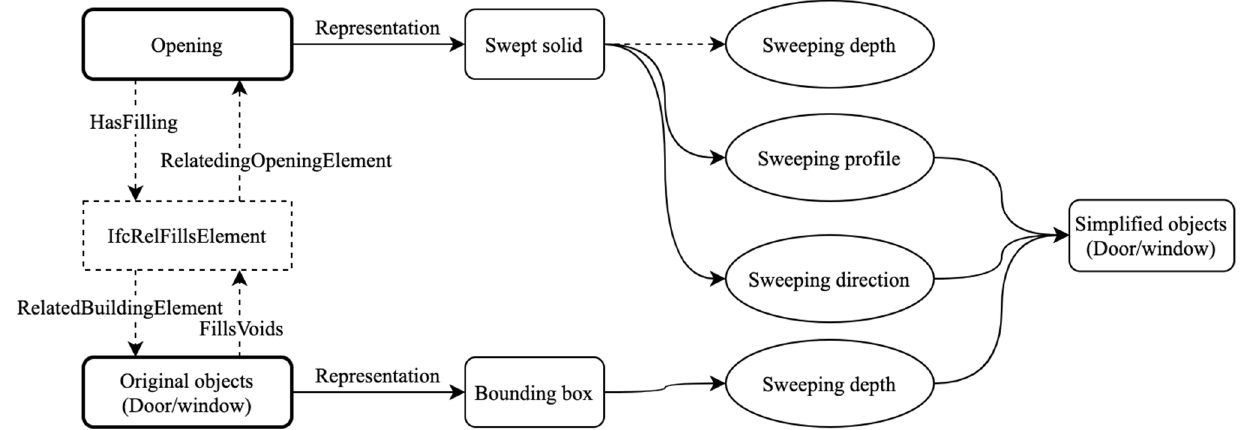
Figure 10. IFC classes involved in the simplification of doors and windows.